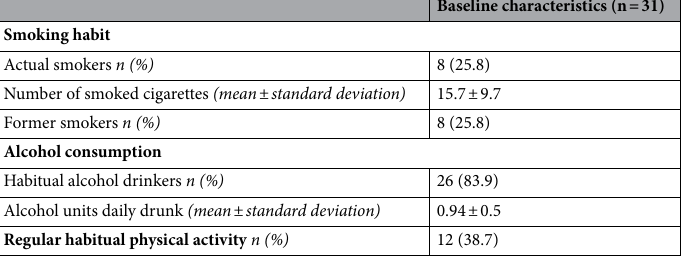
Table 1. Anamnestic characteristics of the 31 subjects enrolled in the